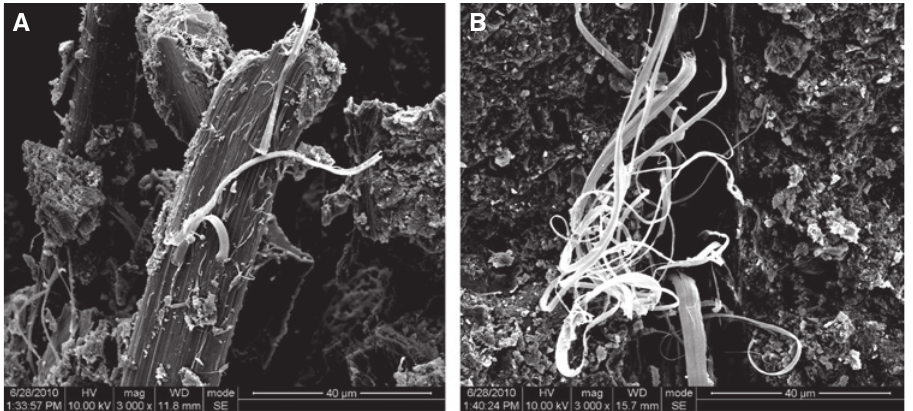
Figure 7: Pullout fibers on the fracture surfaces of the flexural testing sample (A, untreated FRCC; B, treated FRCC).